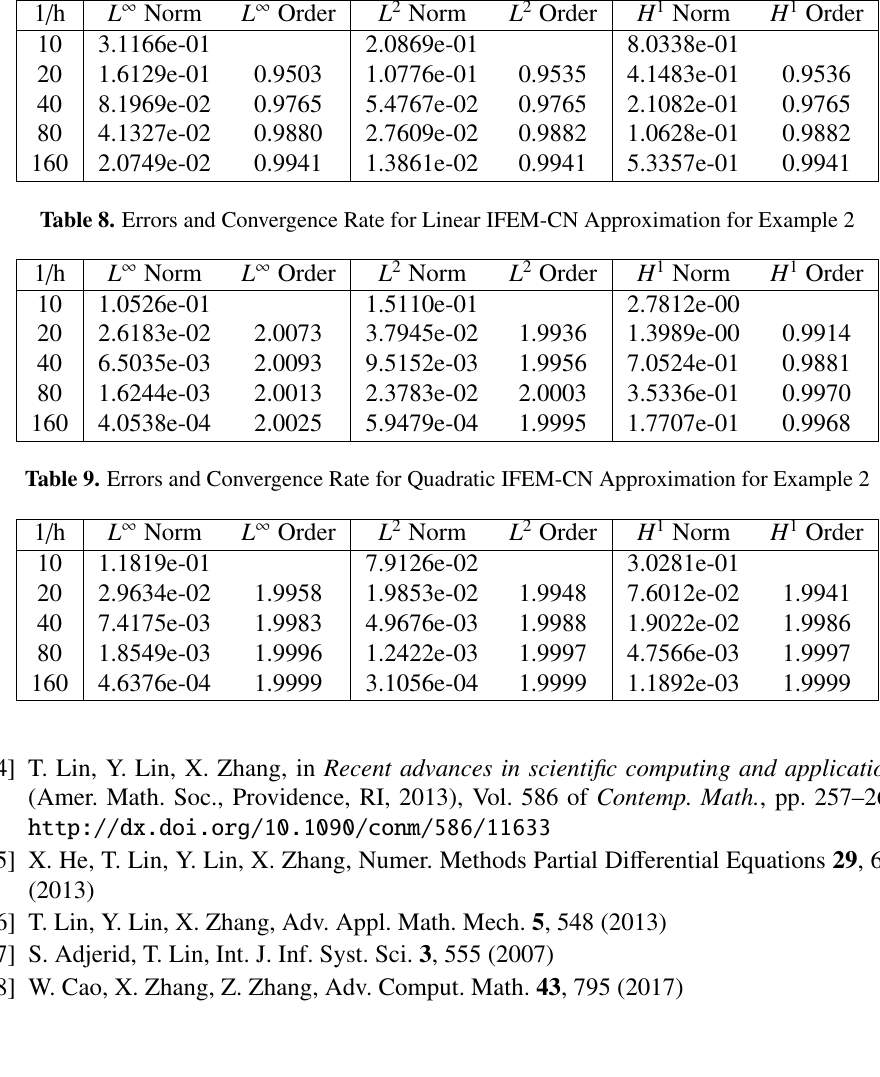
Table 4. Errors and Convergence Rate for Linear IFEM-CN Approximation for Example 1 Table 7. Errors and Convergence Rate for Quadratic IFEM-BE Approximation for Example 2